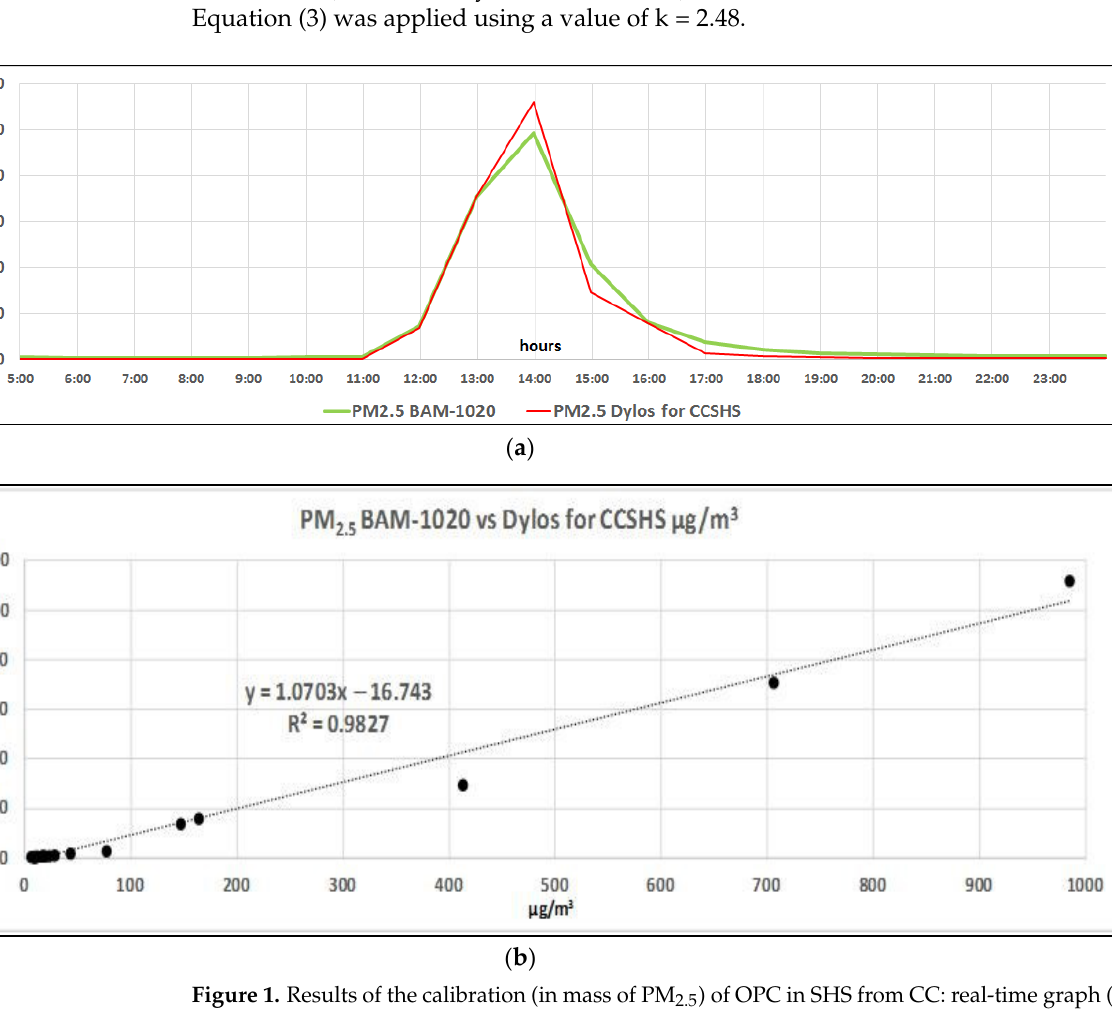
Figure 2. Real-time graph of OPC operating in an ECSHA environment generated by the EC (brand Elips C). No density k factor and regression analysis were possible because the BAM-1020 did not record any appreciable increment attributable with certainty to ECSHA during the use of the e-cig session. The BAM-1020 ’s average PM 2.5 during the e-cig session showed only a minor in- crease from the background, from 4.0 to 6.3 µg/m 3 , while the Dylos measurements in- creased from 2.2 to 18.3 µg/m 3 , with a maximum value of 38.7 µg/m 3 (see Table 2).